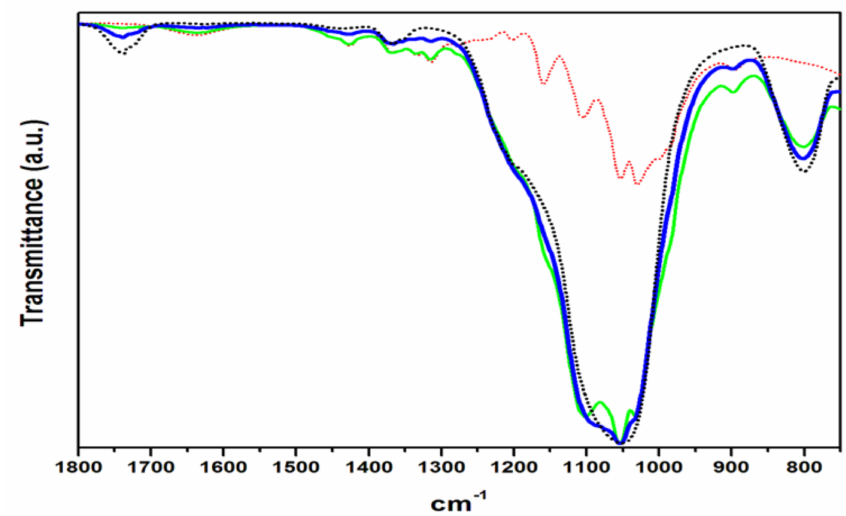
Figure 2. FTIR spectra of AG20 (red dot line), NSi (black dot line), CP3 (green line), CP4 (blue